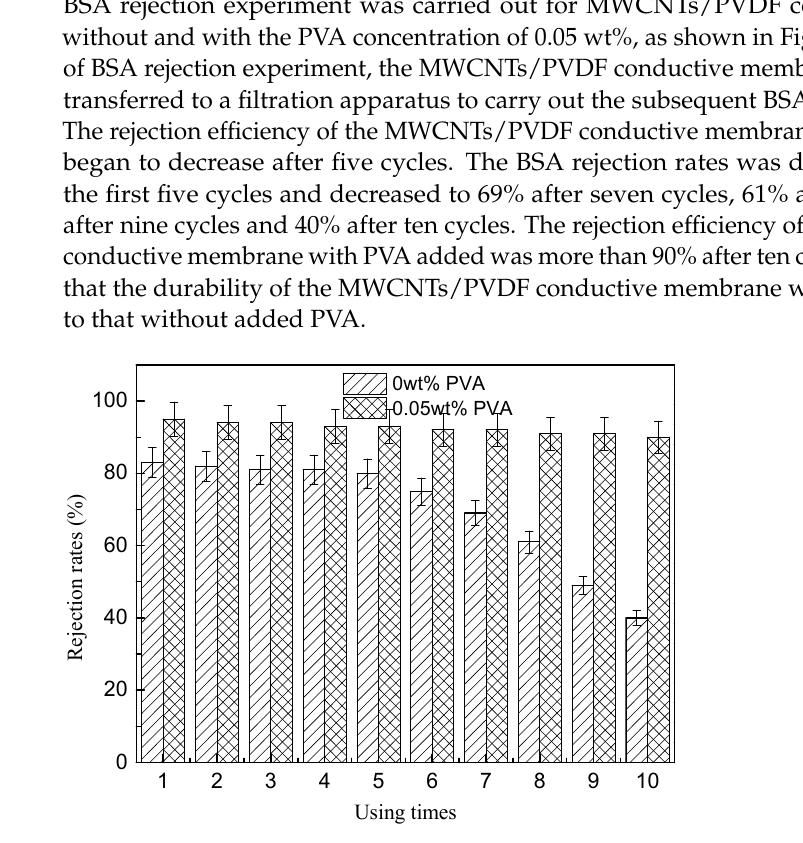
Figure 10. The durability of the MWCNTs/PVDF conductive membrane without and with PVA.